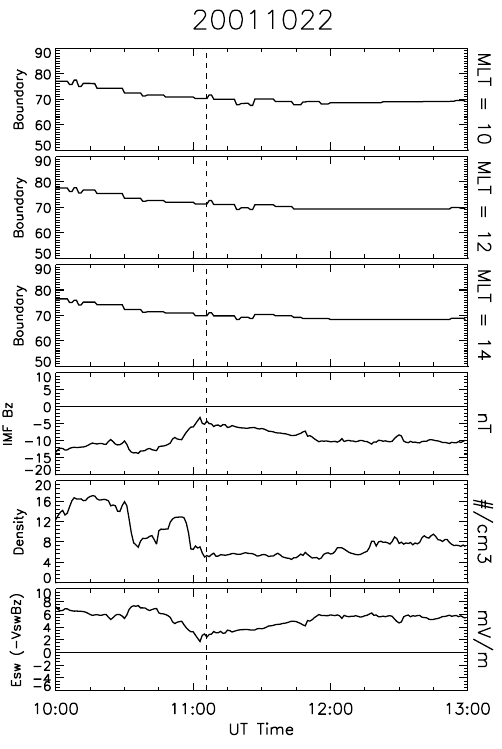
Fig. 7. A stack plot of the dayside boundaries for the individual sawtooth on 22 October 2001. The set up is the same as Fig. 4. The vertical line shows the onset of the injection as measured from geosynchronous